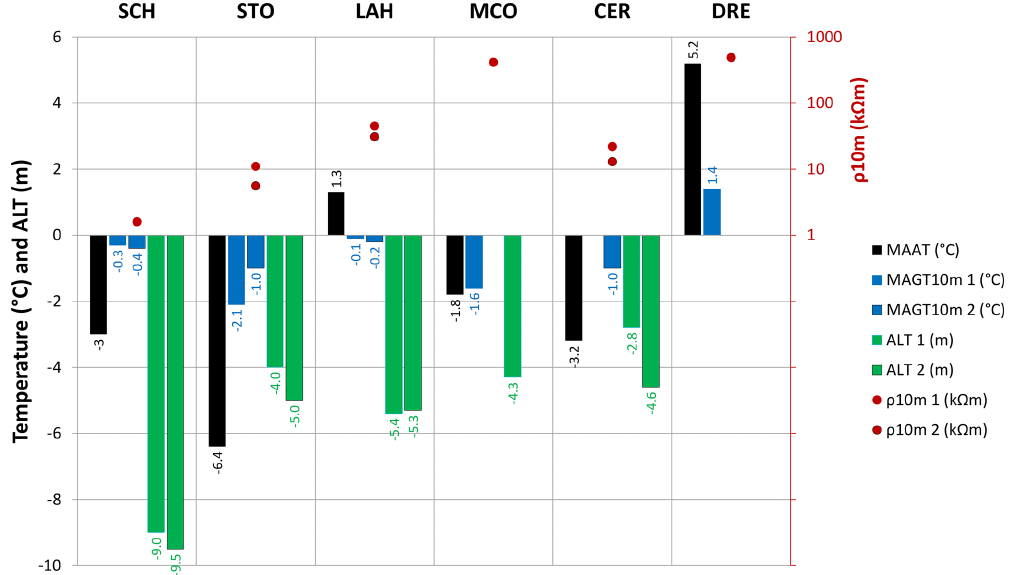
Figure 2. Temperature key information of the monitoring sites, including mean annual air temperature (MAAT), active layer thickness (ALT) of 2017, mean annual ground temperature at 10m depth (MAGT10m), and the average resistivity ( ρ 10m) at around 10m depth at the borehole location (extracted from all available datasets), a depth where temporal variability and corresponding errors from discontinuous measurements are small. Where available, data are given for two boreholes (1 and 2). No ALT data exist for DRE due to unfrozen conditions in the borehole. MAAT and borehole data from PERMOS database (PERMOS, 2016), Arenson et al. (2010), and Pogliotti et al.